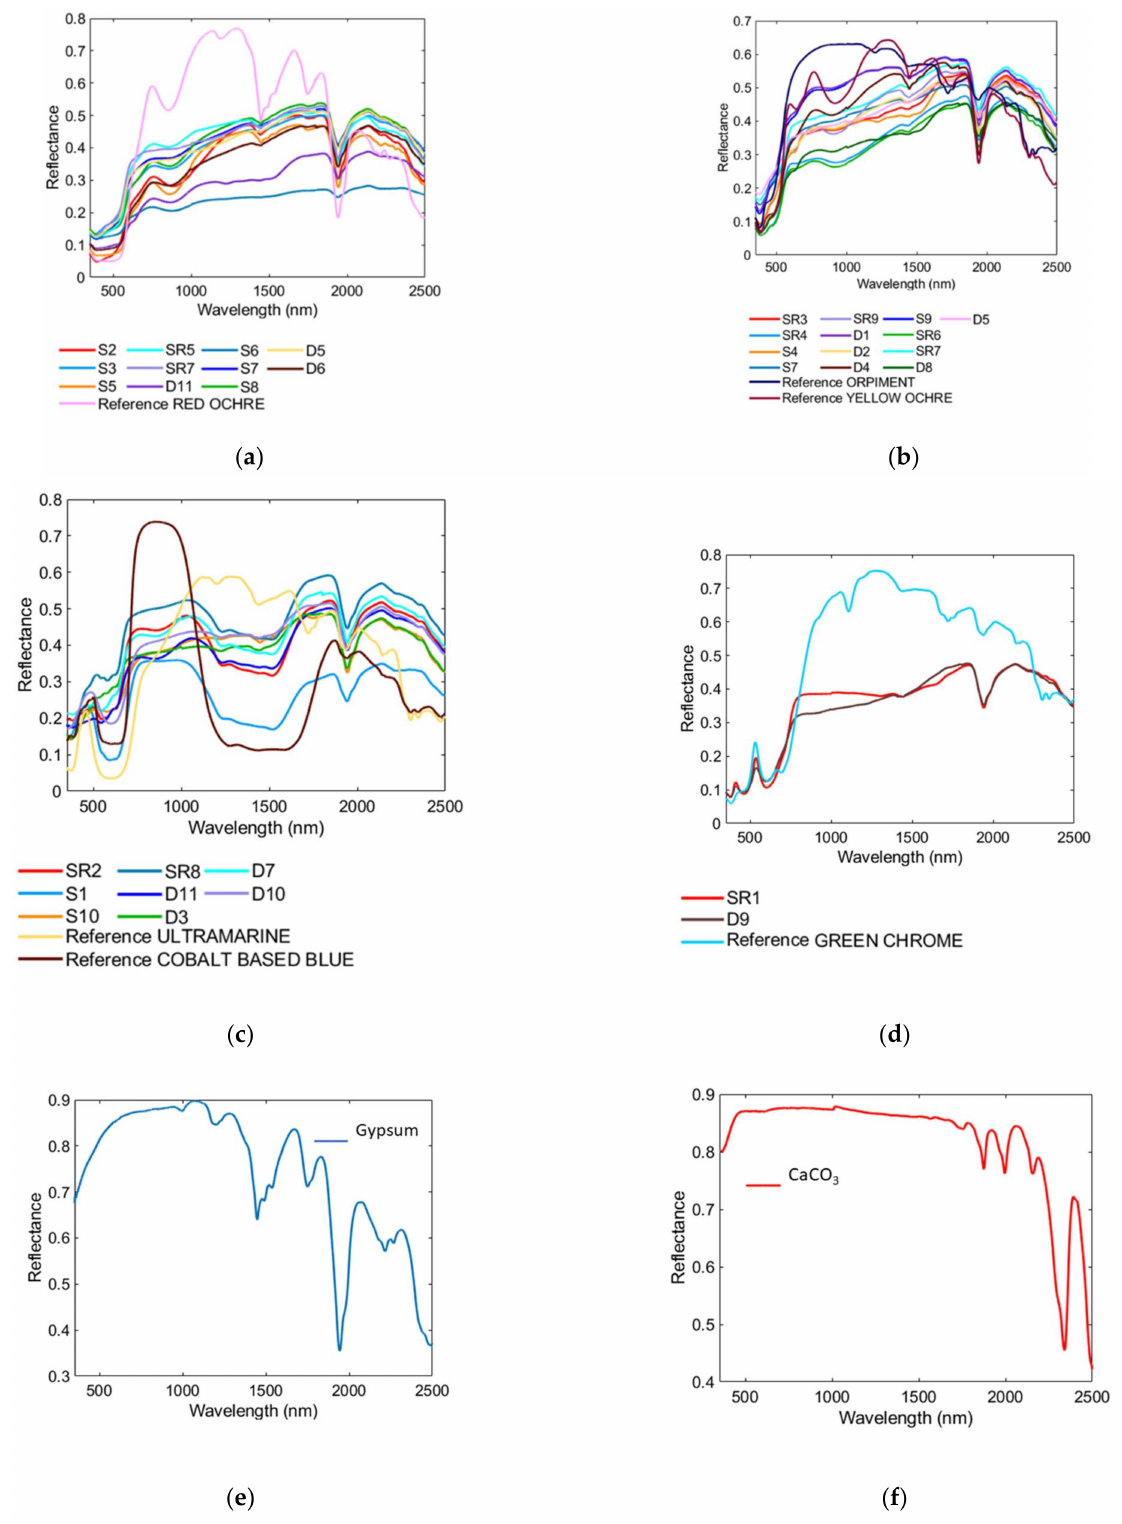
Figure 3. Mean spectra and reference class pigments of the main color group identify: red ( a ), yellow ( b ), blue and purple ( c ), green ( d ). Reference spectra of gypsum ( e ) and calcium carbonate, CaCO 3 ( f ). Finally, the green areas (Figure 2: SR1 and D9) are identified as chrome green (Cr 2 O 3 ), defined also as viridian, by a double absorption at 606 and 696 nm [38] (Figure